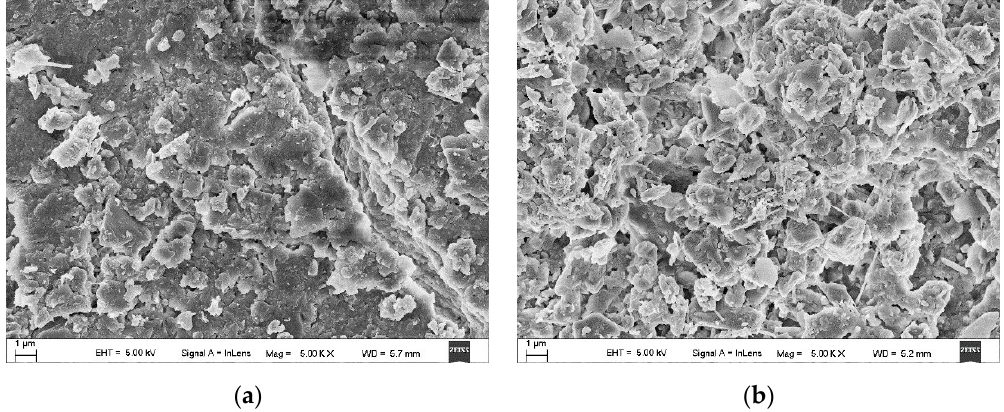
Figure 1. Scanning electron microscopy (SEM) images (5000 × ) of the natural pollutions on the surface of the insulator ( a ) Sampling point 1, ( b ) sampling point 2.